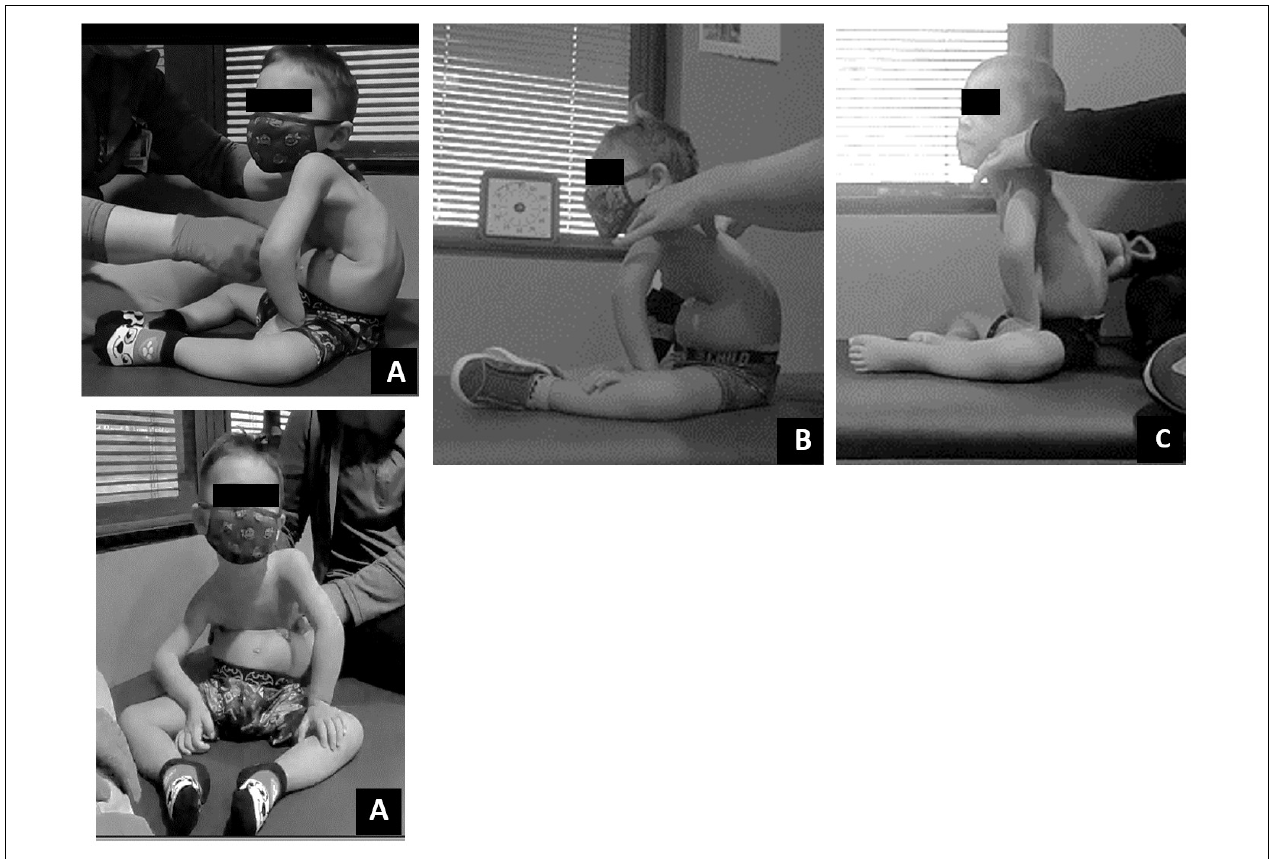
FIGURE 4 | Dependent sitting posture change over time. (A) Initial evaluation – lateral and frontal view. Sacral sitting with lower extremity abduction and external rotation, sharp flexion in trunk at low ribs with kyphotic upper trunk. Right lateral trunk collapse. (B) Twenty sessions evaluation. Pelvic alignment demonstrates less sacral sitting with change toward vertical upright alignment. Trunk continued to demonstrate forward lean/kyphotic posture. (C) Discharge evaluation. Trunk alignment less kyphotic/more upright toward vertical position while pelvis maintained more vertical alignment toward neutral pelvic